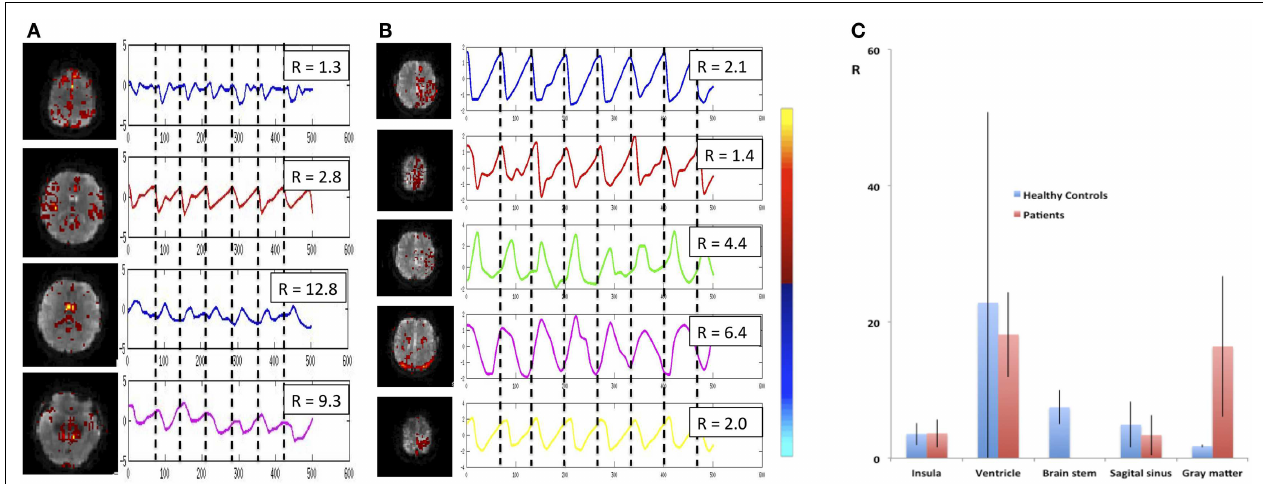
in the AVM and in adjacent gray matter regions.The ratio R of the power spectrum amplitudes at the cardiac frequency versus the first harmonic is shown in the insets. (C) Group analysis across healthy controls ( n = 9) and patients ( n = 6) shows regional differences in R (ratio of the power spectrum amplitudes at the cardiac frequency versus the first harmonic).The color scale for ICA is shown between (B) and (C)